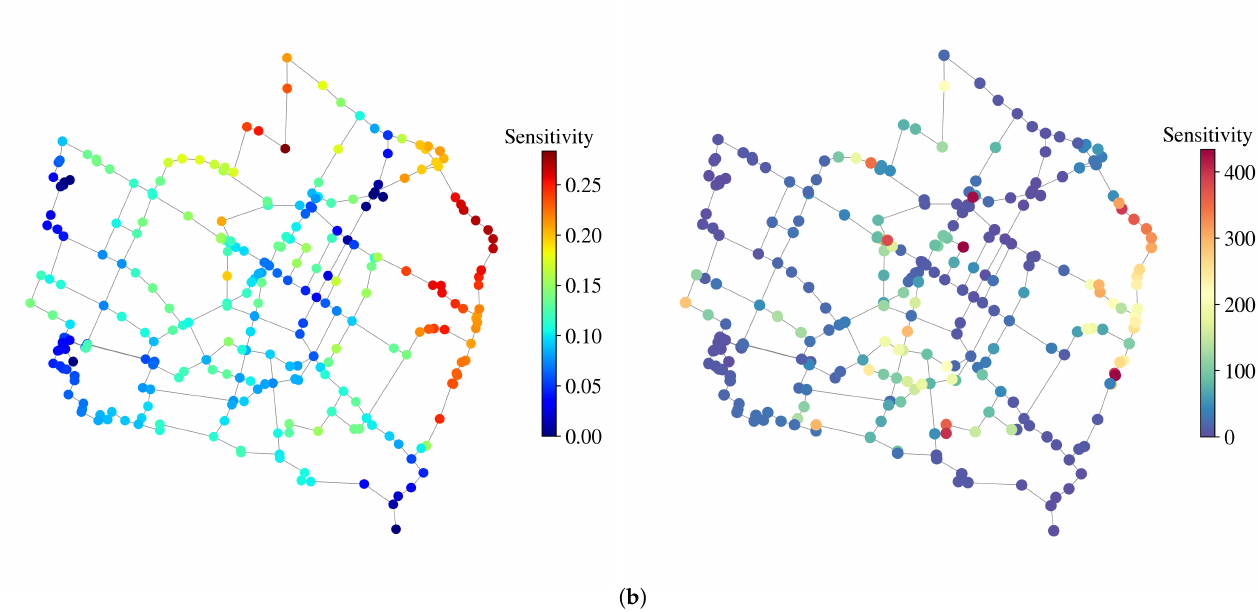
Figure 2. Sensitivity map: ( a ) pressure and ( b ) quality. The sensitivity for both parameters (Figure 2) is lower at nodes around the